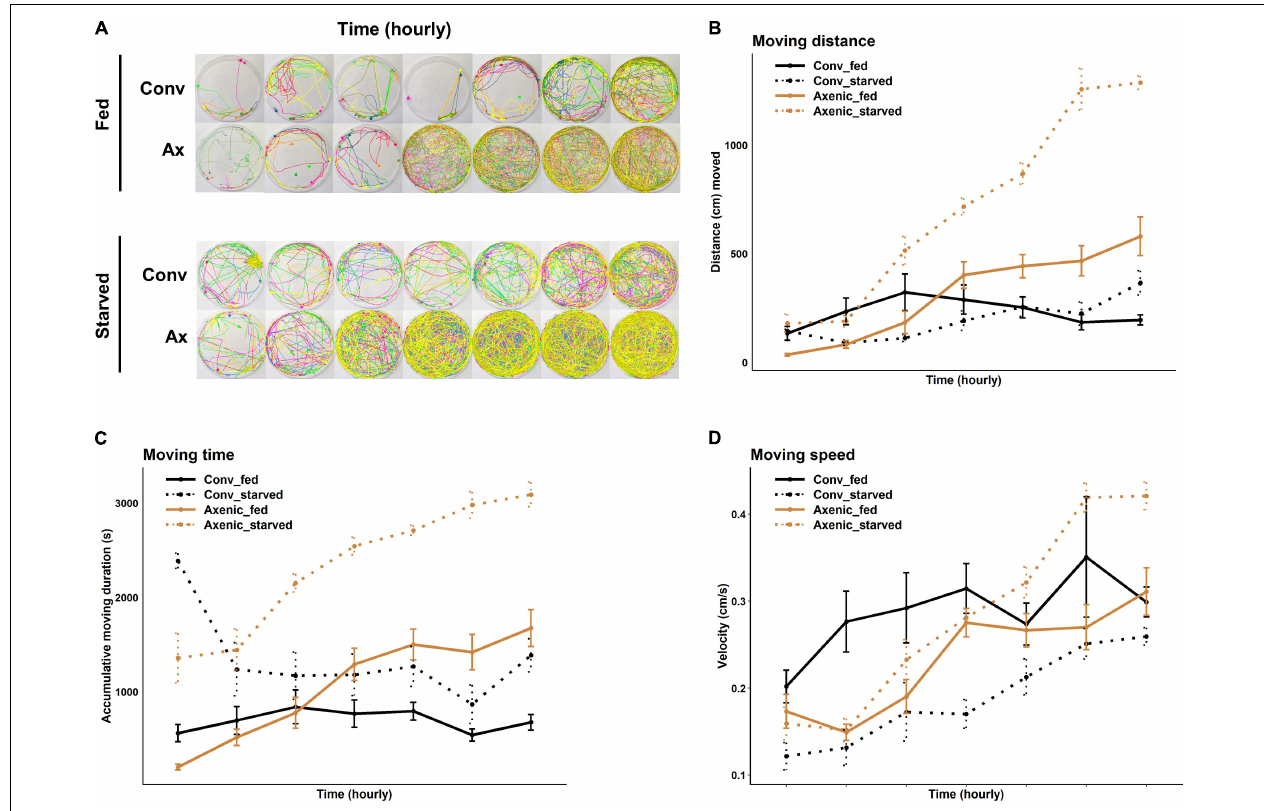
FIGURE 2 | Effects of the microbiome on locomotor activities of fed or starved female Drosophila suzukii . (A) Movement profiles of groups of eight conventional (Conv) and axenic (Ax) flies in the locomotion assay at 1 h intervals. (B) Hourly moving distance, (C) moving time, and (D) moving speed of fed or starved conventional flies (black lines) and axenic flies (golden lines) during the 7 h. (B–D) Fed conventional flies, n = 16; starved conventional flies, n = 16; fed axenic flies, n = 16; starved axenic flies, n = 16. n indicates the number of flies tracked. The error bars represent the means ± SEM (standard error of the means). All pairwise comparisons were analyzed with two-sample t -tests after meeting the normality assumption with Shapiro–Wilk test. Full statistical details are in Supplementary Table 2